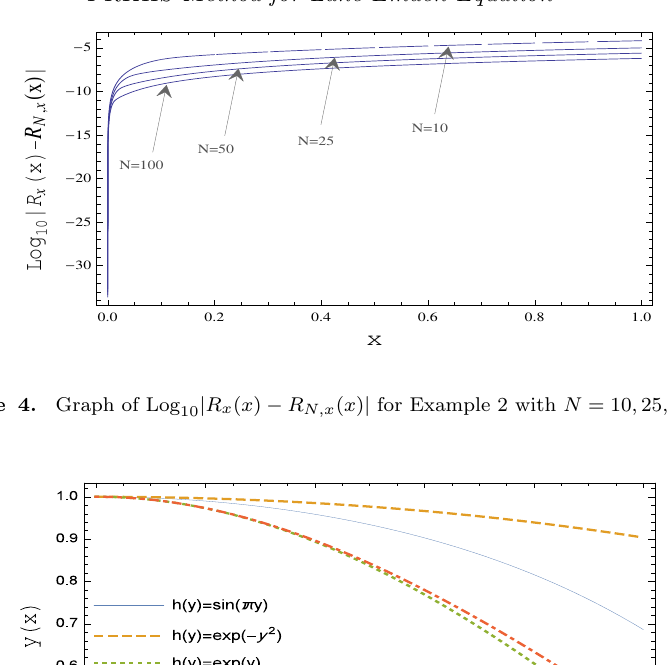
sin ( πy ) 7 . 74872 × 10 − 5